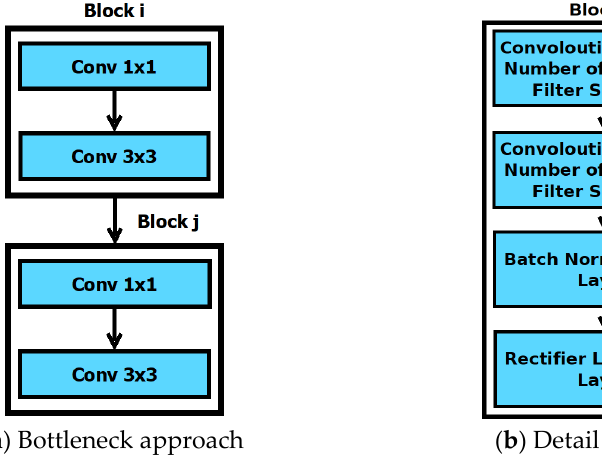
Figure 7. Bottleneck approach and details of blocks.